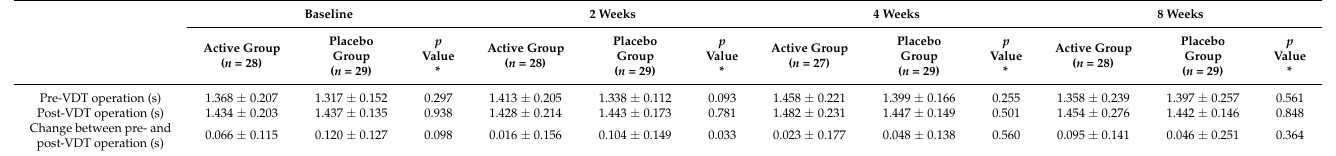
Table 4. The results of smooth-pursuit eye movement tests.